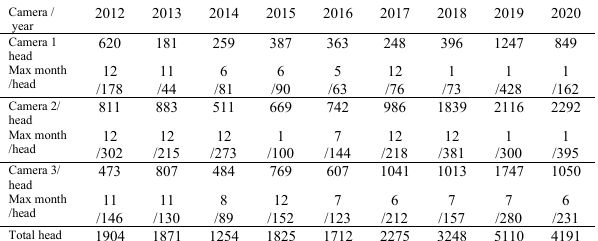
Table 1 . Number of sika deer recorded with sensor cameras in FIWSC.